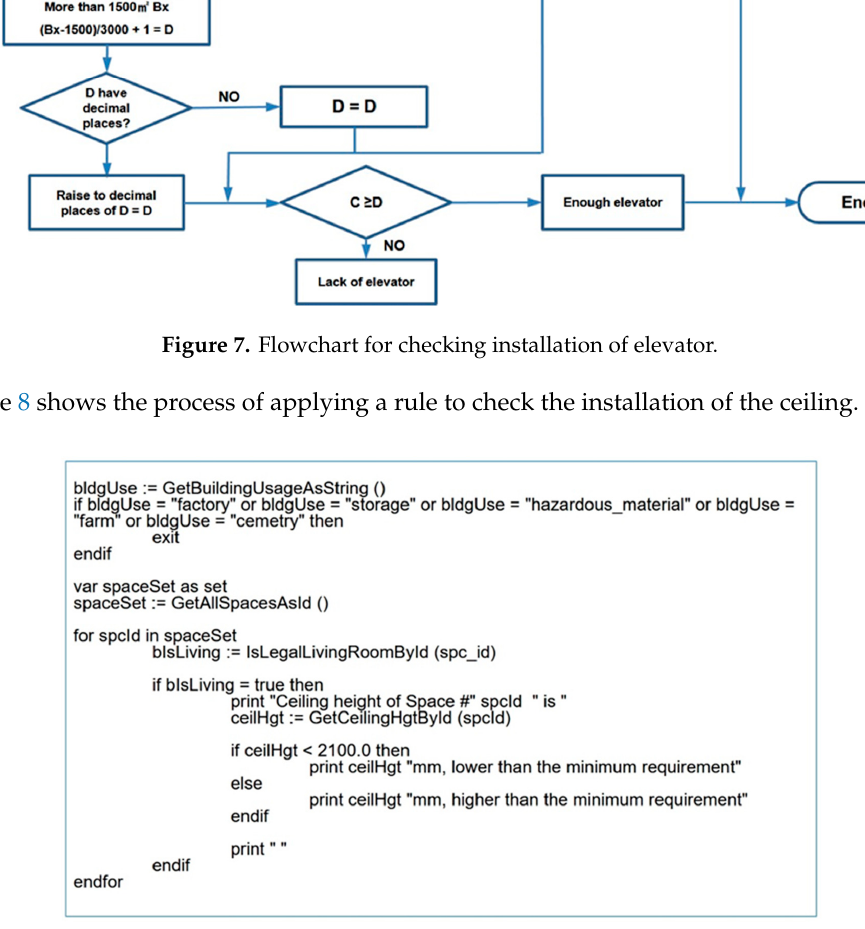
Figure 8. Example of scripting using rule (e.g., installation of ceiling).